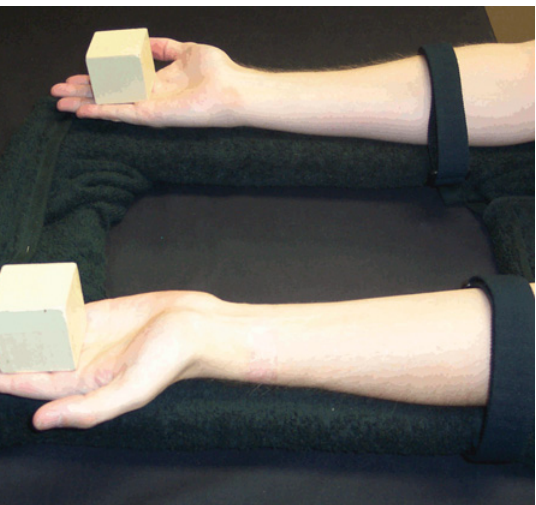
Fig 12. Blocks resting on participant's hands. In Condition 4, an experimenter slid the action block down the participant's arm to the Velcro strap. In Condition 5, neither block was moved.